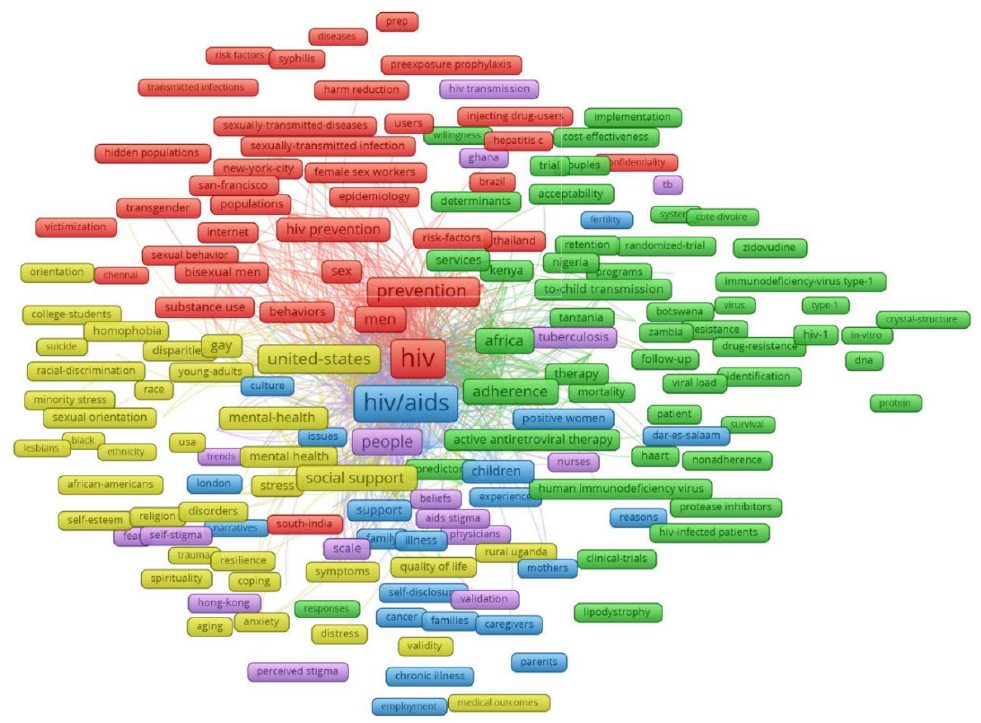
Figure 3. Co-occurrence of most frequent author’s keywords. Note: the colors of the nodes refer to principal components of the data structure; the nodes size was scaled to the keywords’ occurrences; the thickness of the lines was drawn based on the strength of the association between two